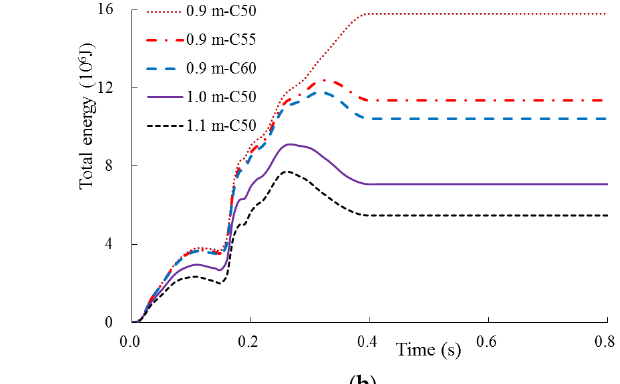
Figure 25. Max plastic strain time-history of concrete.